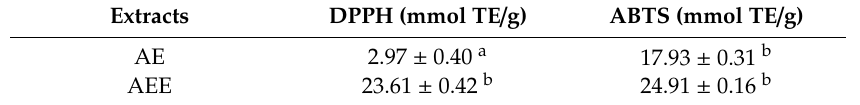
Table 2. Antioxidant e ff ect of Annona muricata L. extracts measured by DPPH and ABTS assay.